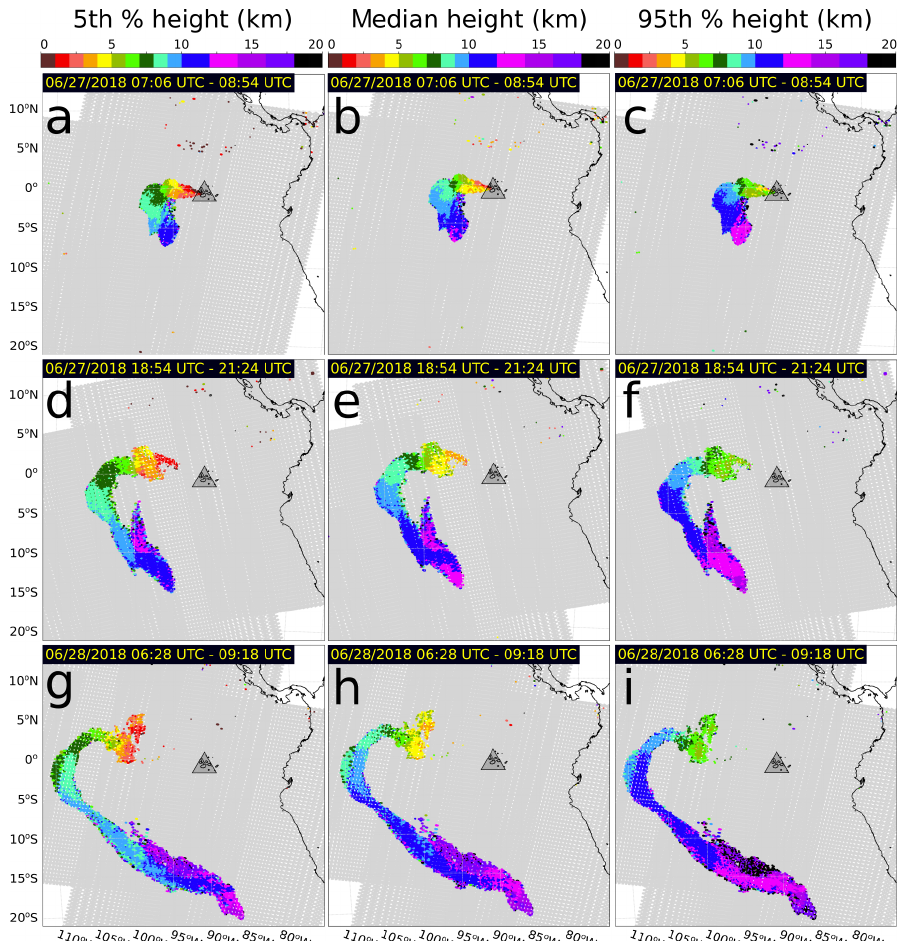
Figure 8. Time evolution (top to bottom) of the 27 June 2018 Sierra Negra SO 2 plume height represented as the 5th percentile (a, d, g) , median (b, e, h) , and 95th percentile (c, f, i) heights. Data are merged SNPP CrIS and NOAA-20 CrIS with SNPP CrIS FOV 7